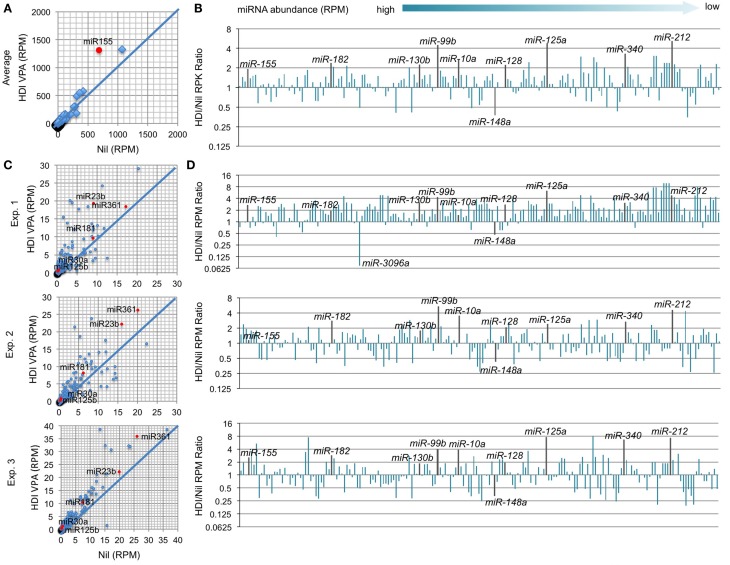
HDI selectively inhibits miRNA expression in B cells induced to undergo CSR and plasma cell differentiation. B cells were cultured with LPS plus IL-4 in the presence of HDI (VPA, 500 μM) or nil for 60 h before preparation of RNA for miRNA-Seq. (A) Scatter plots of average (in three independent experiments) miRNA expression levels (RPMs) in B cells treated with HDI versus that in B cells treated with nil. P values, paired t-test. (B) Bar graphs depict the changes of folds of the average miRNA expression levels (RPMs) in B cells treated with HDI as compared to that in B cells treated with nil. (C) Bar graphs depict the changes of folds of miRNA expression levels (RPMs) in B cells treated with HDI as compared to that in B cells treated with nil, in three independent experiments. (D) Scatter plots of miRNA expression levels in B cells treated with HDI versus those in B cells treated with nil, in three independent experiments. Only the miRNAs at average RPM > 0.5 in LPS plus IL-4-stimulated B cells treated with nil are included.